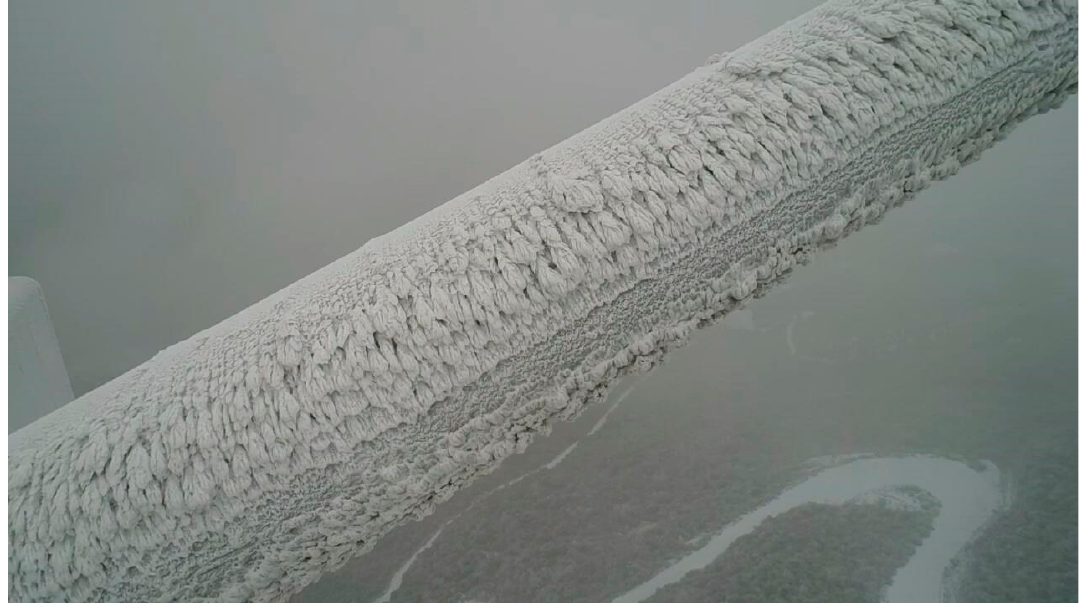
Figure 1. Examples of wind turbine operation in icing conditions.